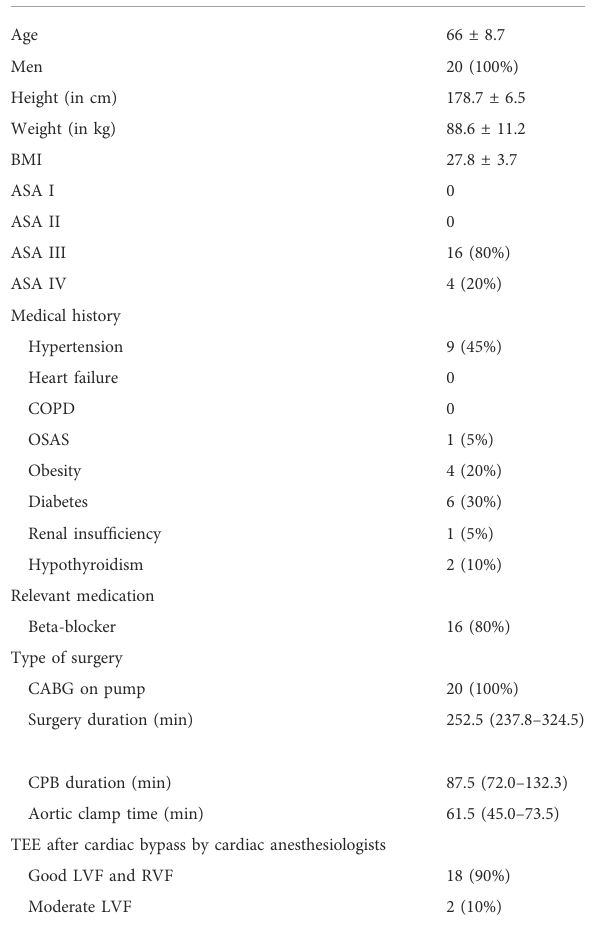
TABLE 1 Baseline